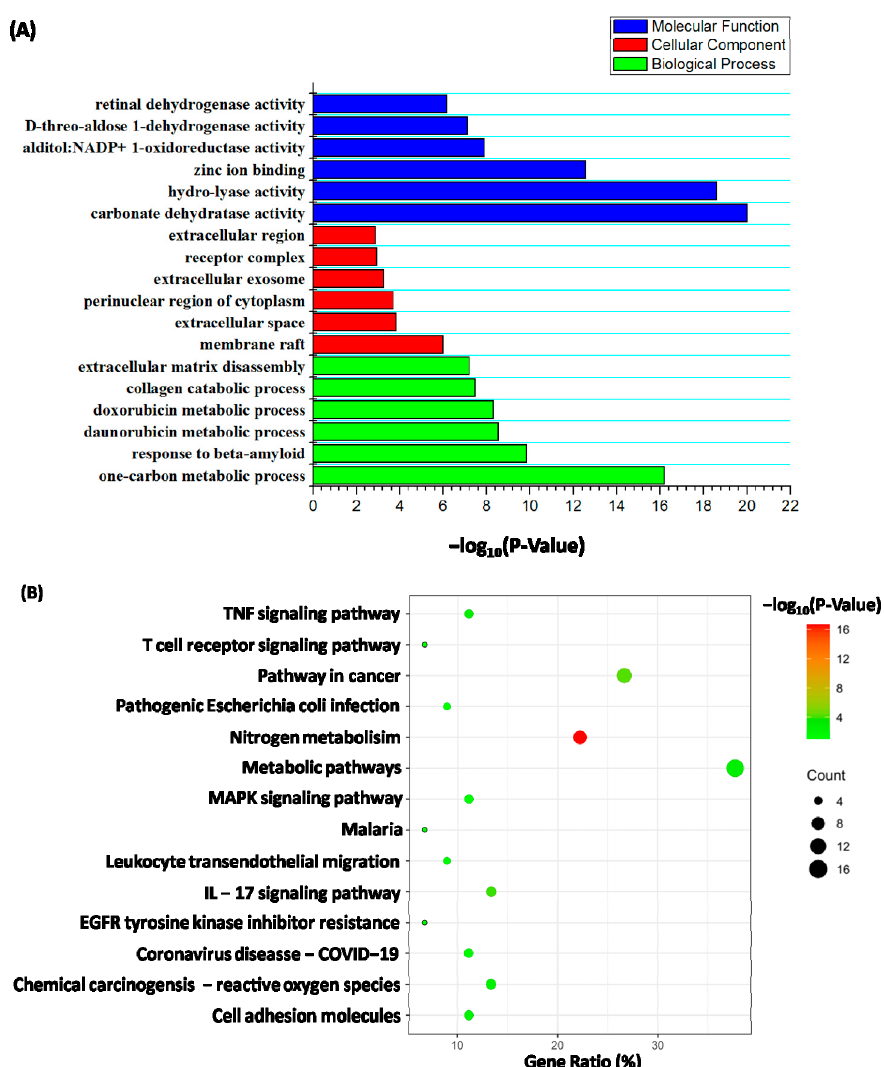
Figure 7. Analysis of the feasible targets toward rosmarinic acid through GO and KEGG enrichment. ( A ) The forecasted targets mostly take part in carbonate dehydratase activity in terms of the molecular function; as for the cellular component, the predicted targets mainly existed in cytosol; one-carbon metabolic is considered the primary progress during the biological process. ( B ) The circle diameter represents the number of rosmarinic acid-related genes. The deeper shield of orange shows the greater disparity. Forecasted genes towards rosmarinic acid (CA12, CA1, CA5B, CA2, CA4, CA7, CA6, CA9, CA14, and CA13) were allocated to the signaling pathway of nitrogen metabolism, with notable